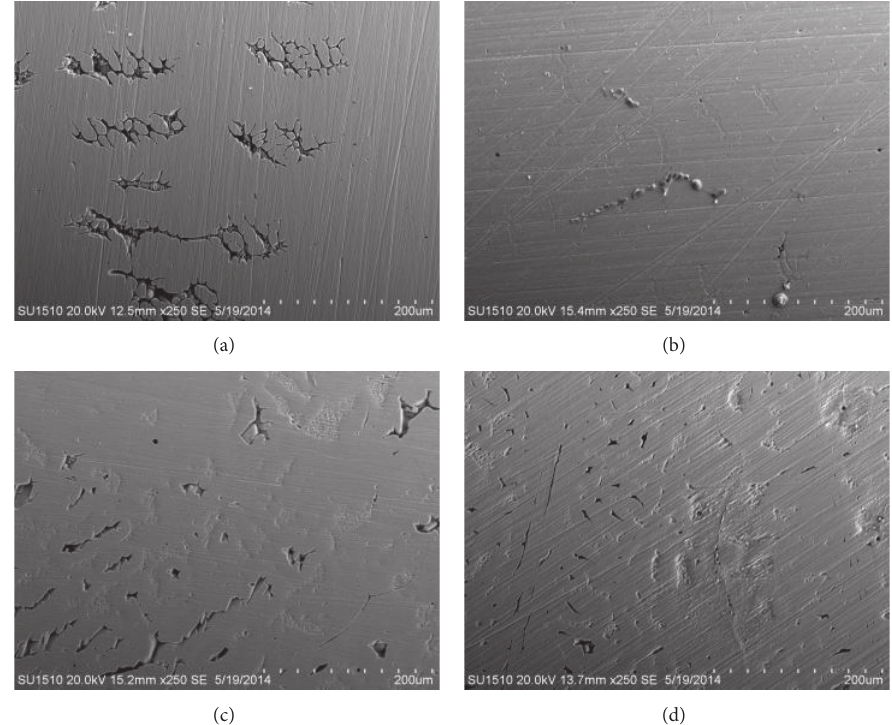
Figure 13: Micrograph of the corroded surfaces of (a) Ni 3 Al, (b) Ni 3 Al-1Cu, (c) Ni 3 Al-3Cu, and (d) Ni 3 Al-3Cu in 1.0M H 2 SO 4 solution at 25 ∘